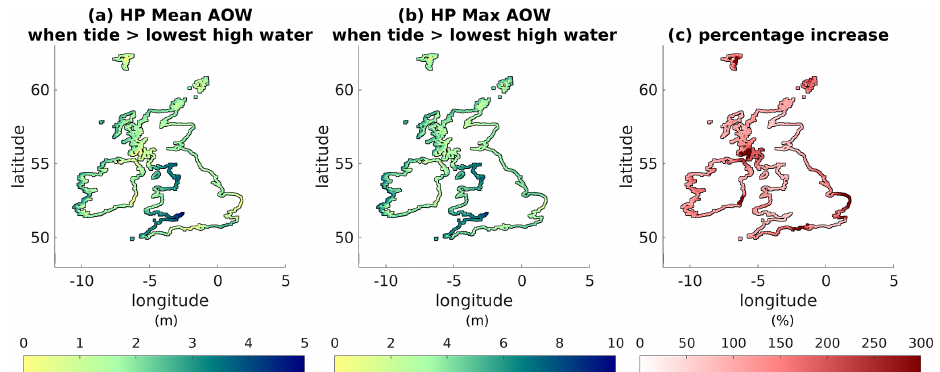
Figure 8. Mean and maximum hazard proxy calculated at each coastal point (a, b) and percentage increase between the mean and maxi- mum (c) . Note that the percentage increase plot was saturated to zero to only focus the positive increase; some regions of the Faroe Islands showed a decrease. Also note that this is the mean of values for winter 2013/4, which is an extreme period; the comparison to a longer climatology simulation could show a higher